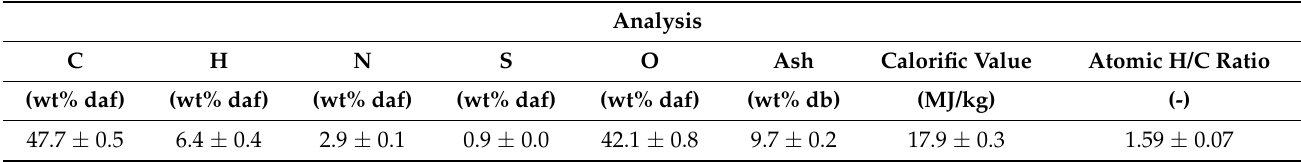
Table 9. Chemical analysis of Jordan’s corn leaf waste [63].